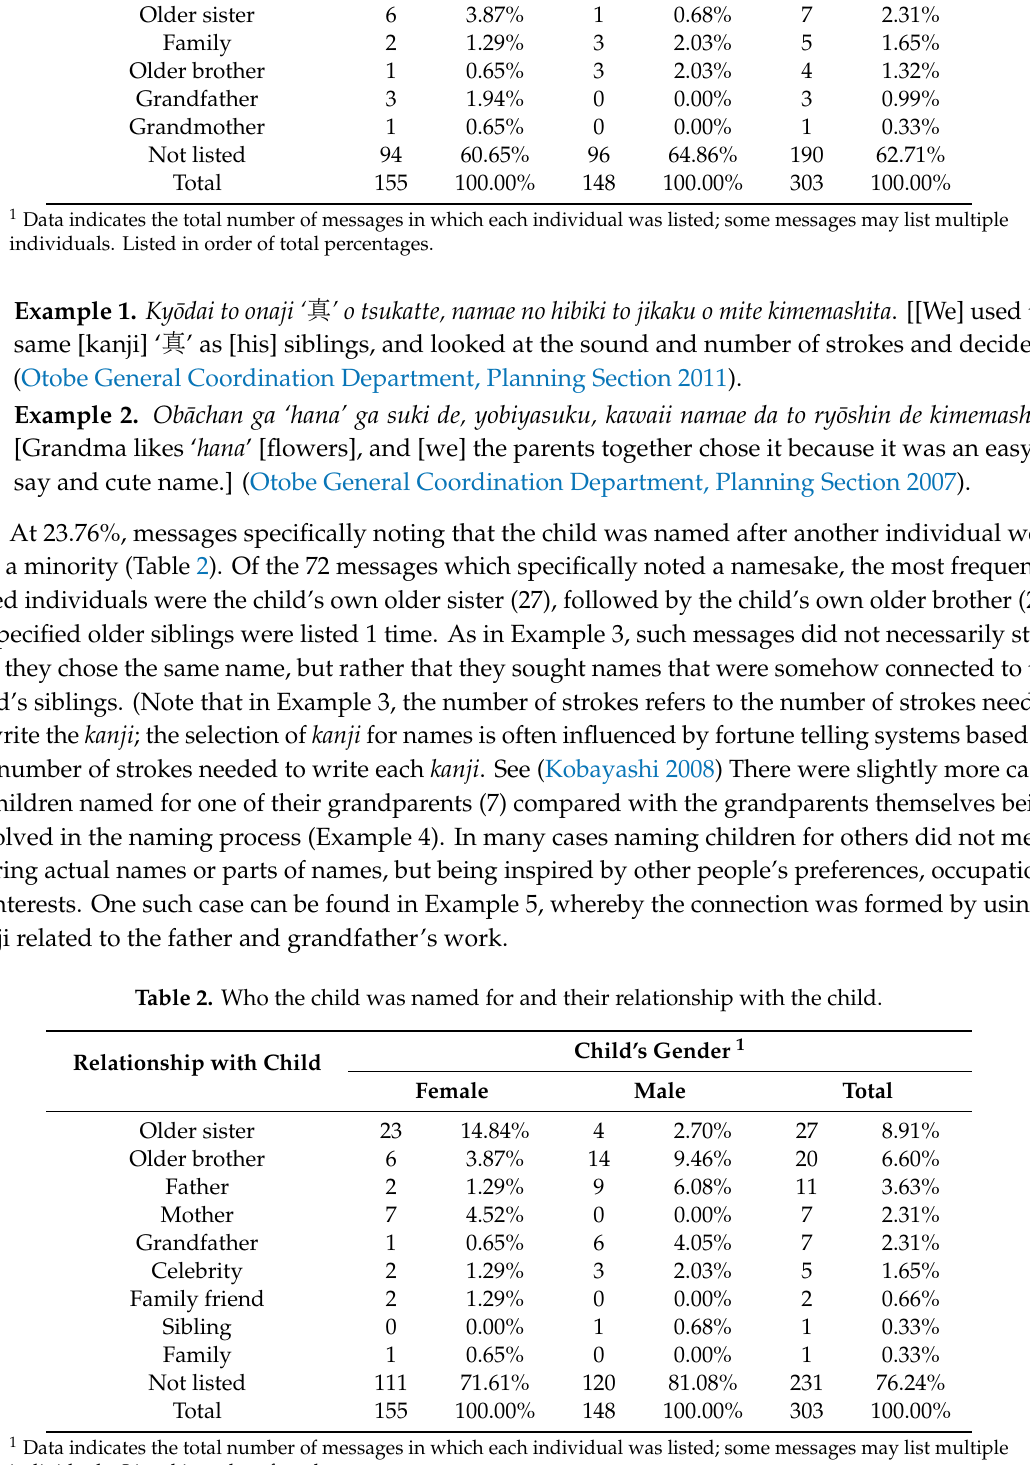
Table 1. Who was noted as being involved in naming the child and their relationship with the child. Relationship with Child